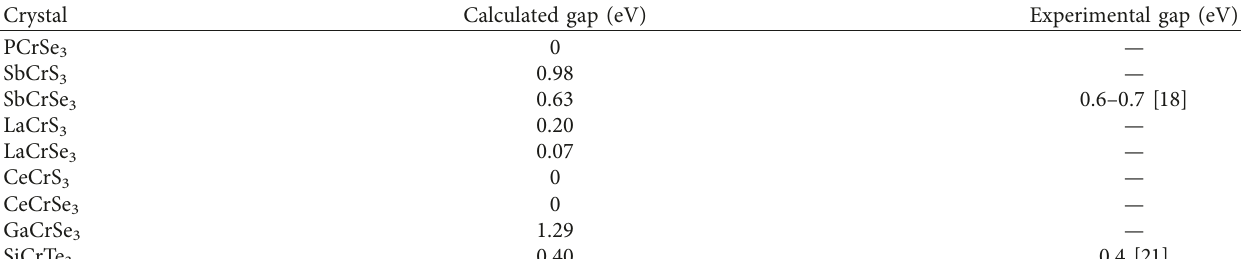
Table 2: Comparison of DFT + U bandgaps with experimental results. Crystal Calculated gap (eV)